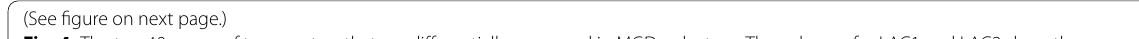
figure on next Fig. 4 The top 40 genes of transporters that are differentially expressed in MGD or lactose. The columns for LAC1 and LAC2 show the gene expression data using 10 g/L lactose as an inducer at 48 h. The columns for MGD1 and MGD2 show the gene expression data using 10 g/L MGD as an inducer at 36 h. Data are shown as a heat map with the following color code of relative expression values (navy: 1; white: 0; firebrick: numbers indicate the log 2 of the relative expression level). The previously reported transporters were